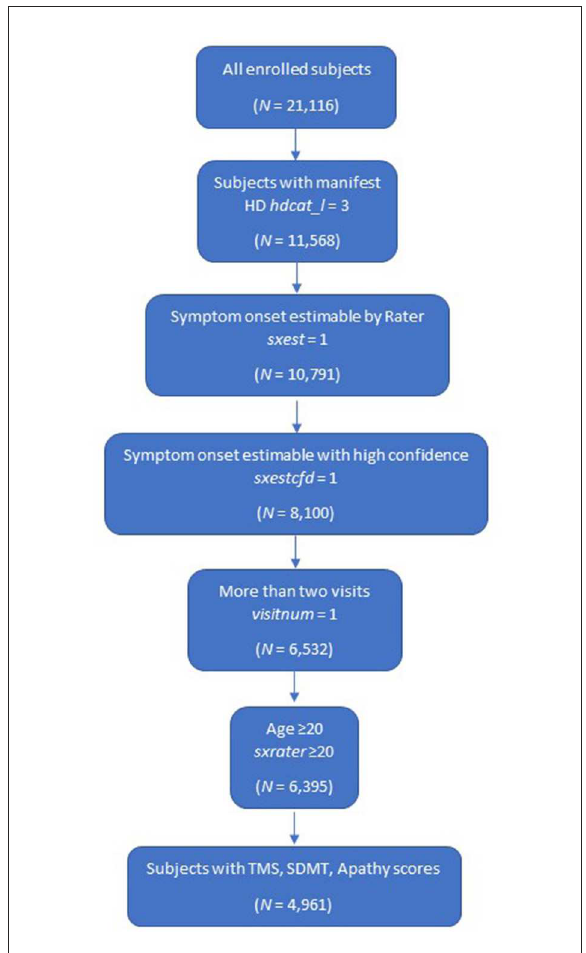
FIGURE1 Study population. HD, Huntington’s disease; SDMT, Symbol Digit Modalities Test; TMS, Total Motor